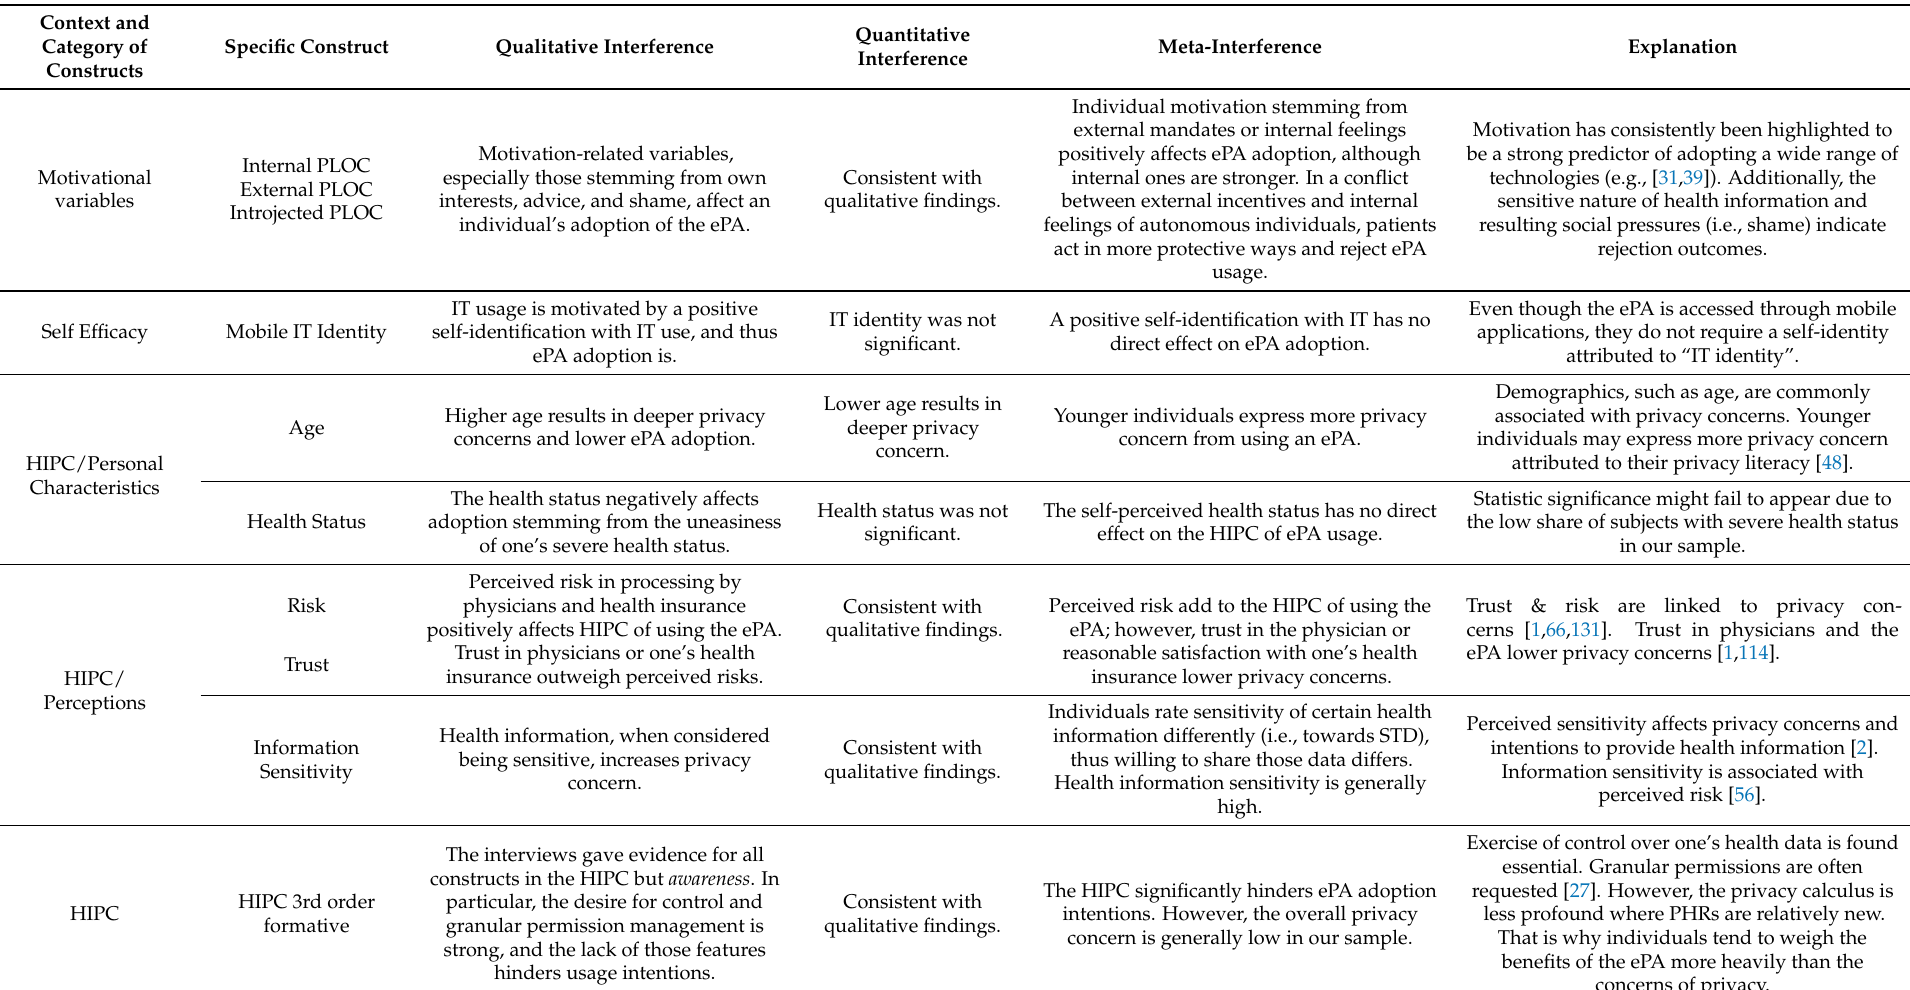
Table 3. Development of qualitative inferences, quantitative inferences, and meta-inferences (adapted from